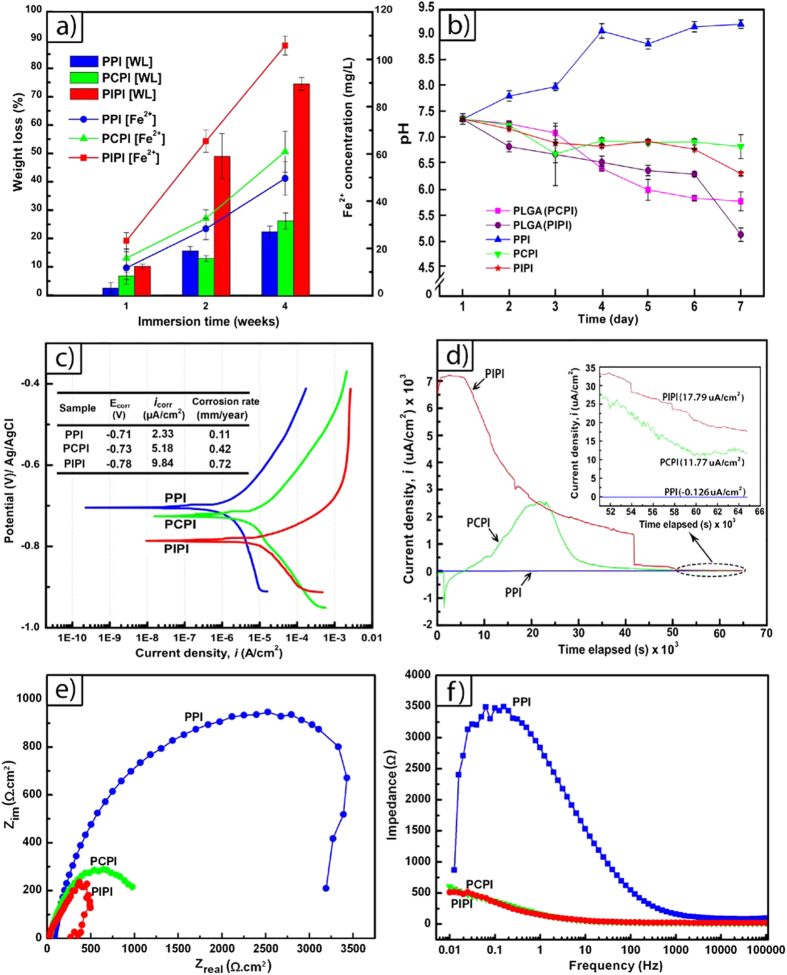
Degradation assessment results:(a) Weight loss (WL) and Fe2+ concentration of PPI, PCPI and PIPI samples after immersion in PBS for 1, 2, and 4 weeks, (b) pH measurement data up to 7 days immersion in PBS. (c) PDP curves of the samples and their corresponding corrosion parameters, (d) PSP curves after 7 days immersion in PBS, (e,f) Nyquist and Bode plots of the samples from the EIS after 2 h exposure to PBS solution.